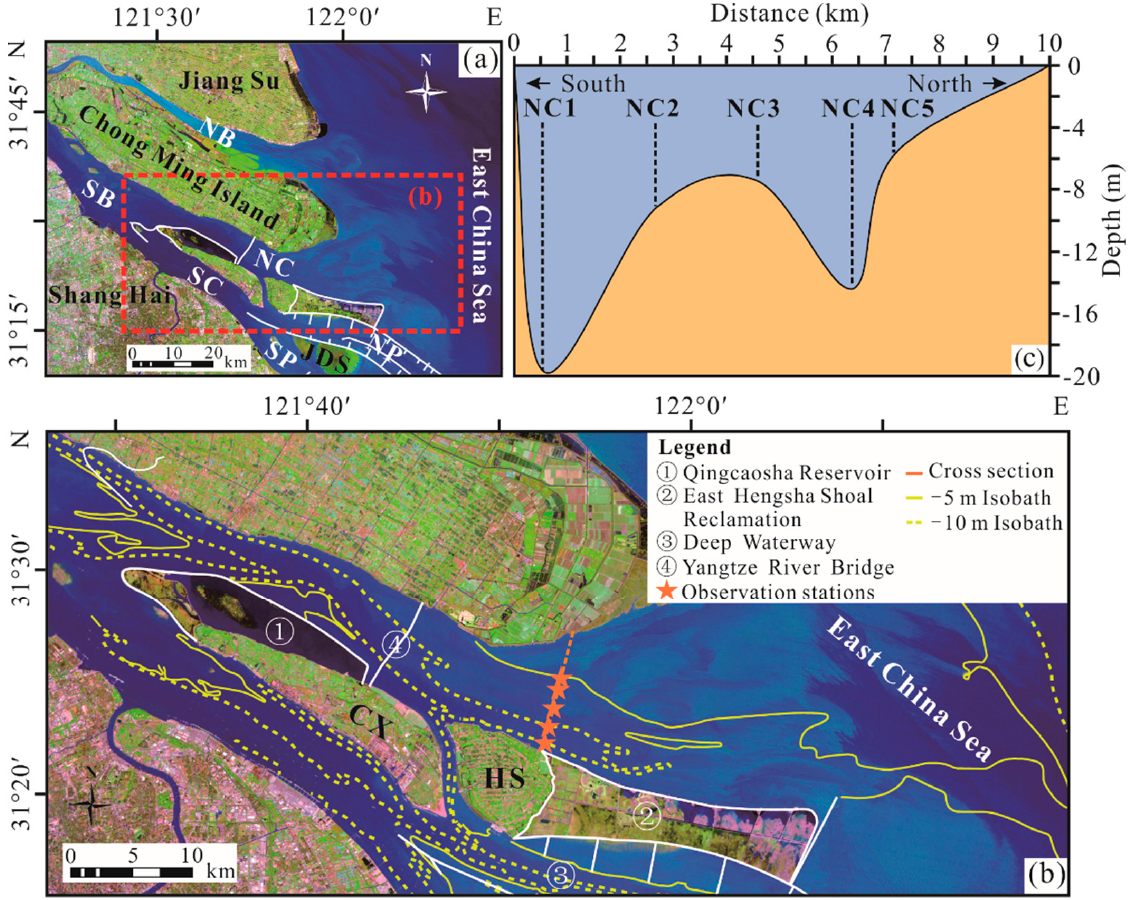
Figure 1. Map showing the study area, with ( a ) the Yangtze estuary, where North Branch, South Branch, North Channel, South Channel, North Passage and South Passage are abbreviated as NB, SB, NC, SC, NP and SP, respectively, Changxing Island, Hengsha Island and Jiuduansha Shoal is represented as CX, HS and JDS, respectively; ( b ) the locations of transection and observation stations; ( c ) the lateral bathymetry of transection, where dashed lines mean vertical measured profiles at five stations.